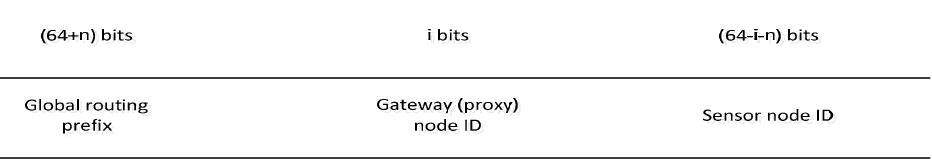
Figure 4. The IPv6 address structure (adapted from [10]).